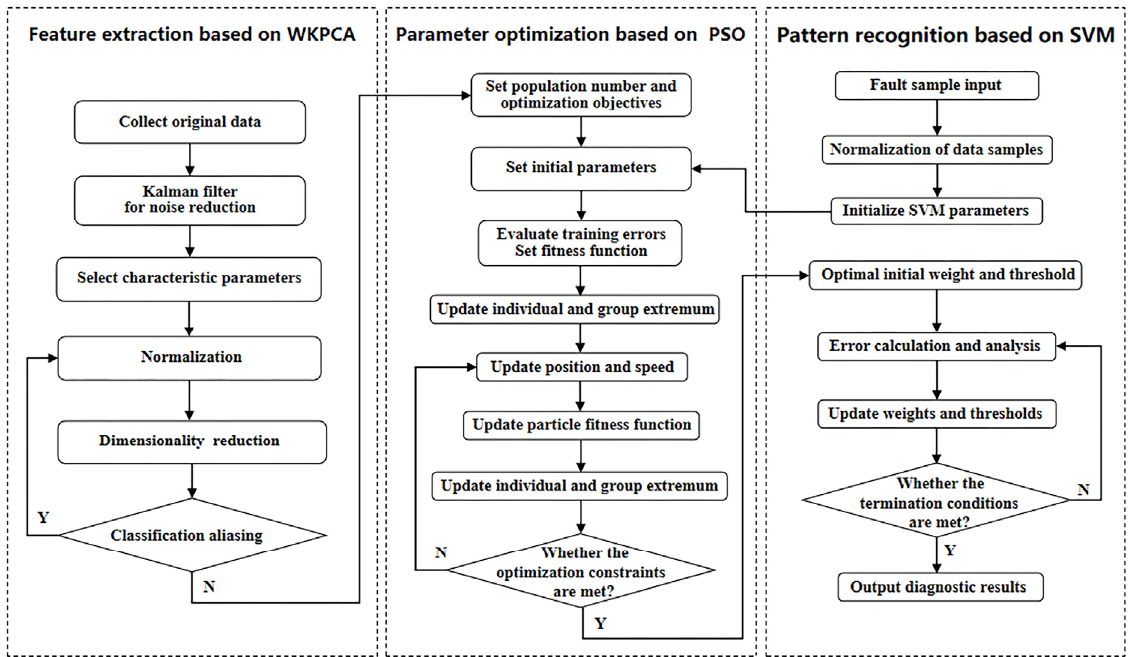
Figure 8. The flow chart based on WKPCA and PSO-SVM algorithm.